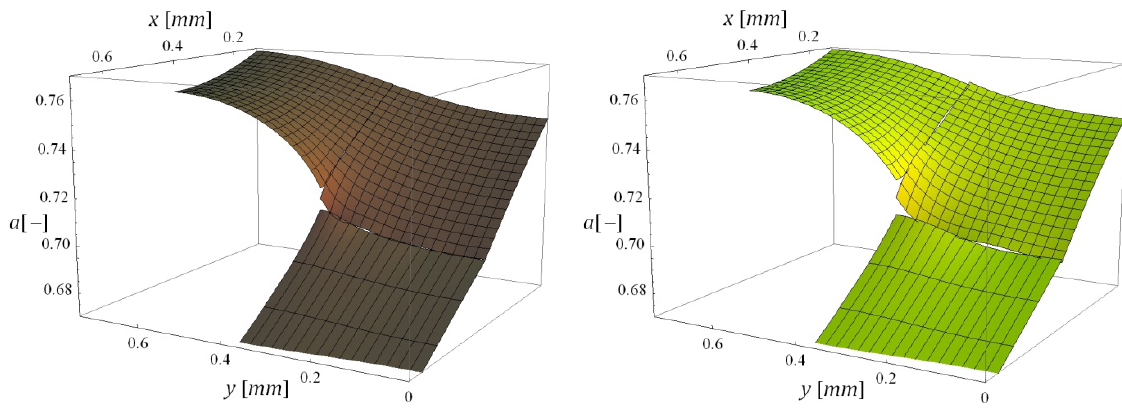
Figure 17. Comparison between HAN concentration distribution in cathode GDL domains and part of cathode channel domain of the slice that is midway between inlet and outlet is